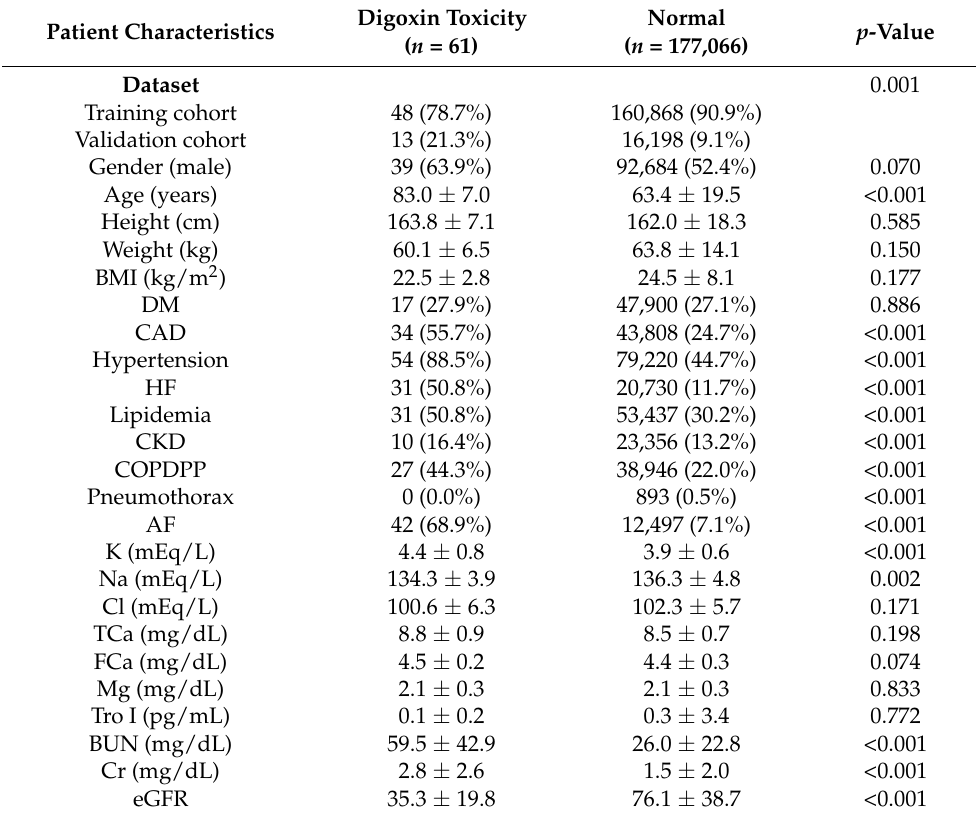
Table 1. Corresponding patient characteristics and laboratory results in digoxin toxicity ECGs and normal